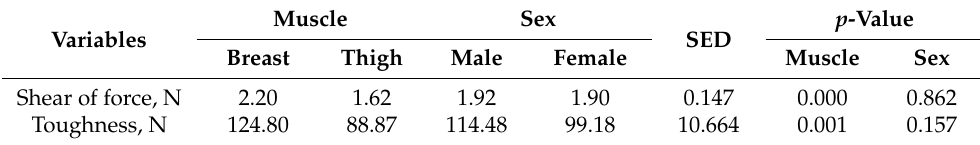
Table 6. Effects of muscle anatomical location and goose sex on Warner-Bratzler test parameters.